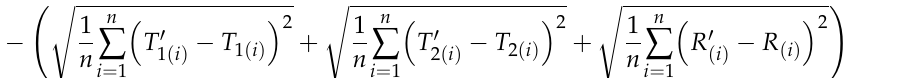
Figure 6. The histogram of FOMs for the generated devices of five different power-splitting ratios, which are generated by ( a ) WGAN, or ( b ) WGAN-sim, respectively. The red dashed line indicates the averaged proportion of the devices with FOM over 0.8 for all five cases. With the help of sim-NN, the performance of the generated device has a significant improvement, where the proportion of devices with an FOM over 0.8 can increase by